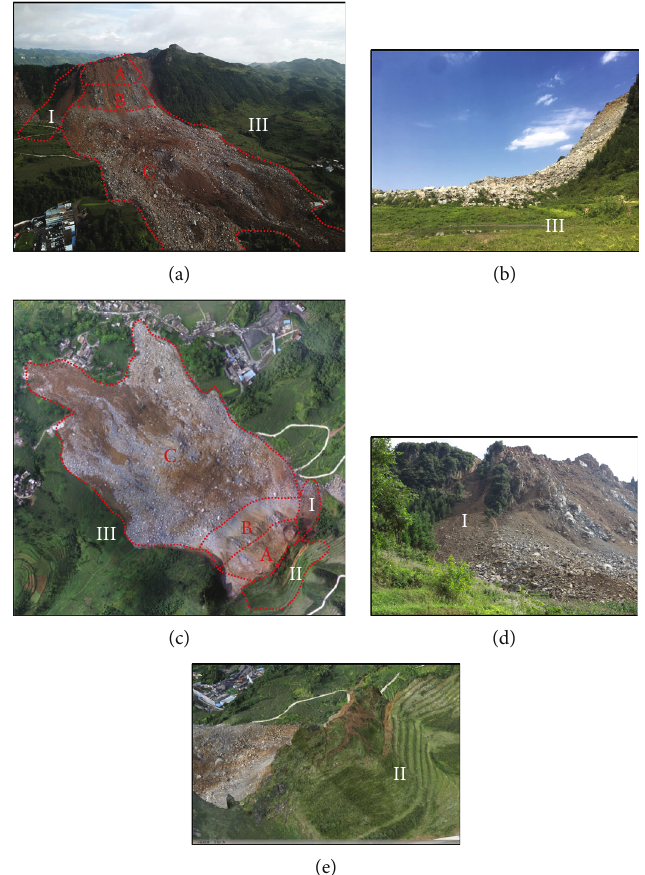
Figure 2: Overview of the Pusa landslide: (a) full view; (b) side view; (c) UAV image; (d) deep crack; (e) ground fi ssures behind the